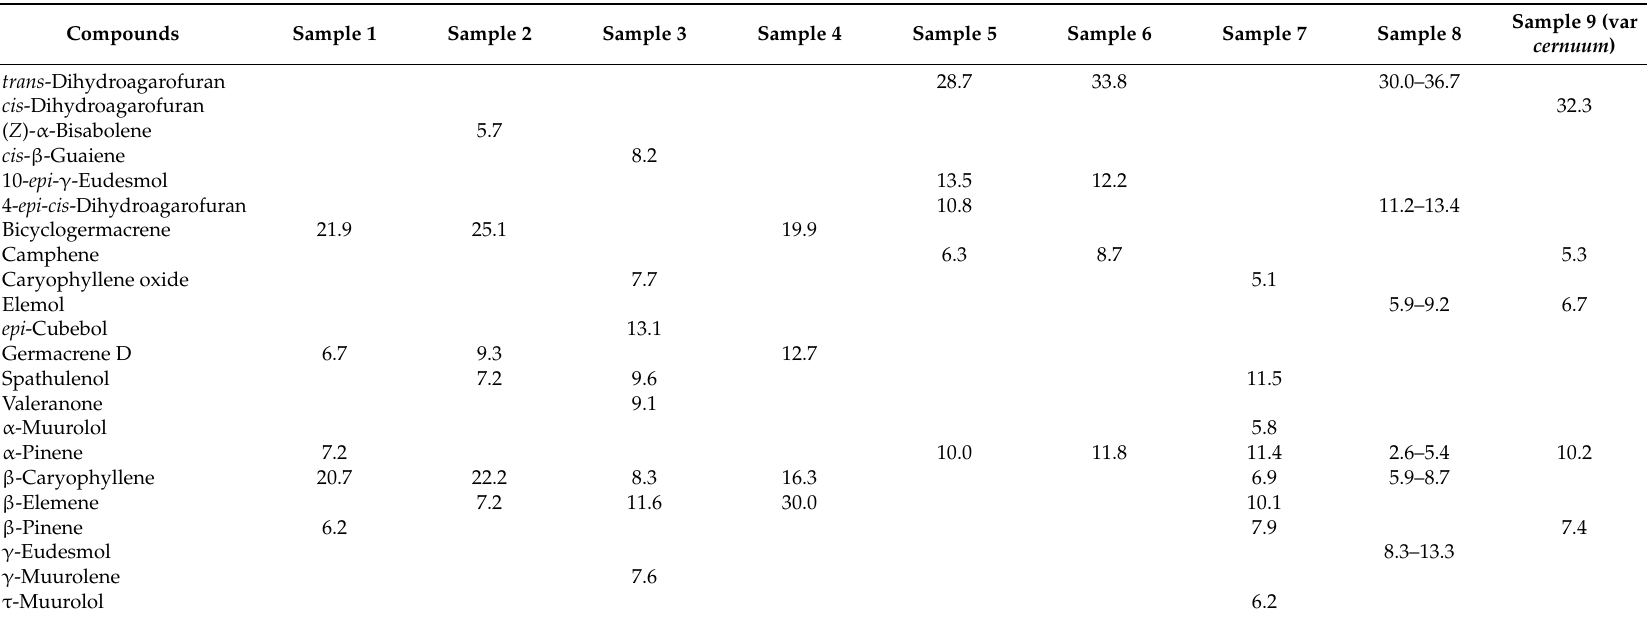
Table 15. Chemical compositions (%) of Piper cernuum Vell. Leaf essential oils from Brazil